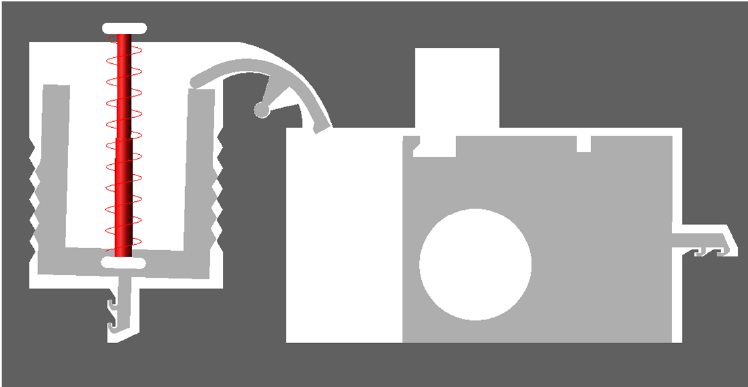
Figure 13. The position of the rotary pin and locking state.